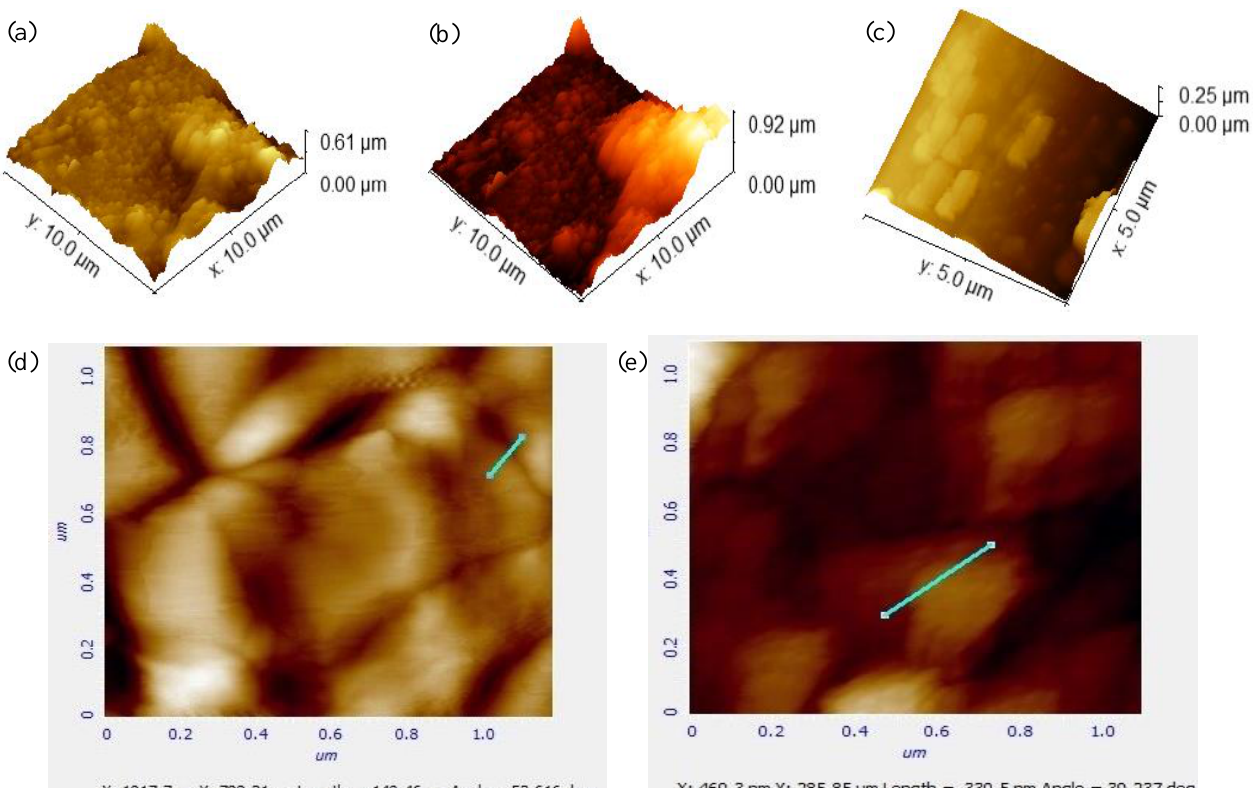
Figure 5. AFM images of ( a ) pure Pregabalin, ( b ) Pregabalin-loaded gel, ( c ) Pure extract ( d ), Pregab- alin + extract-loaded gel, and ( e ) Extract-loaded gel.